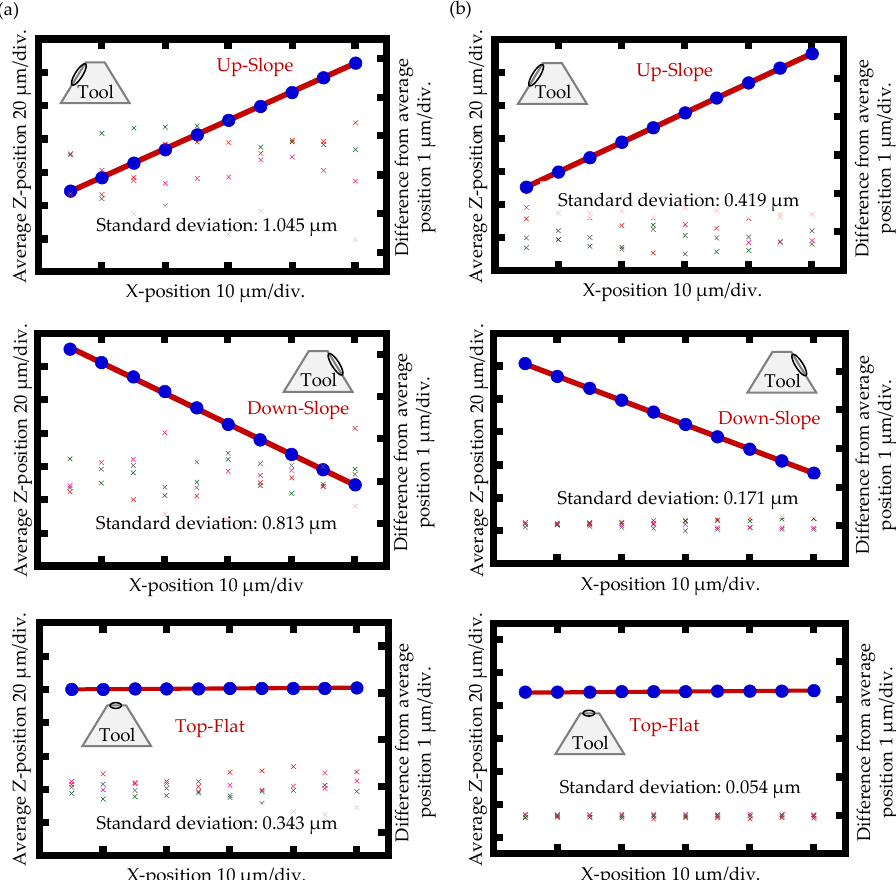
Figure 10. Cutting edge measurement results: ( a ) Measured by the cantilever beam profiler; ( b ) measured by the double-sided beam profiler.